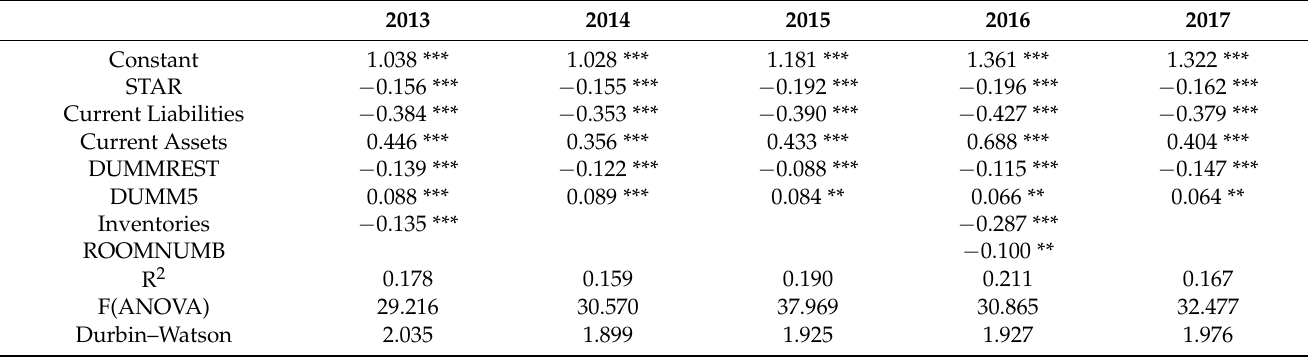
Table 13. Log-linear regression of Quick